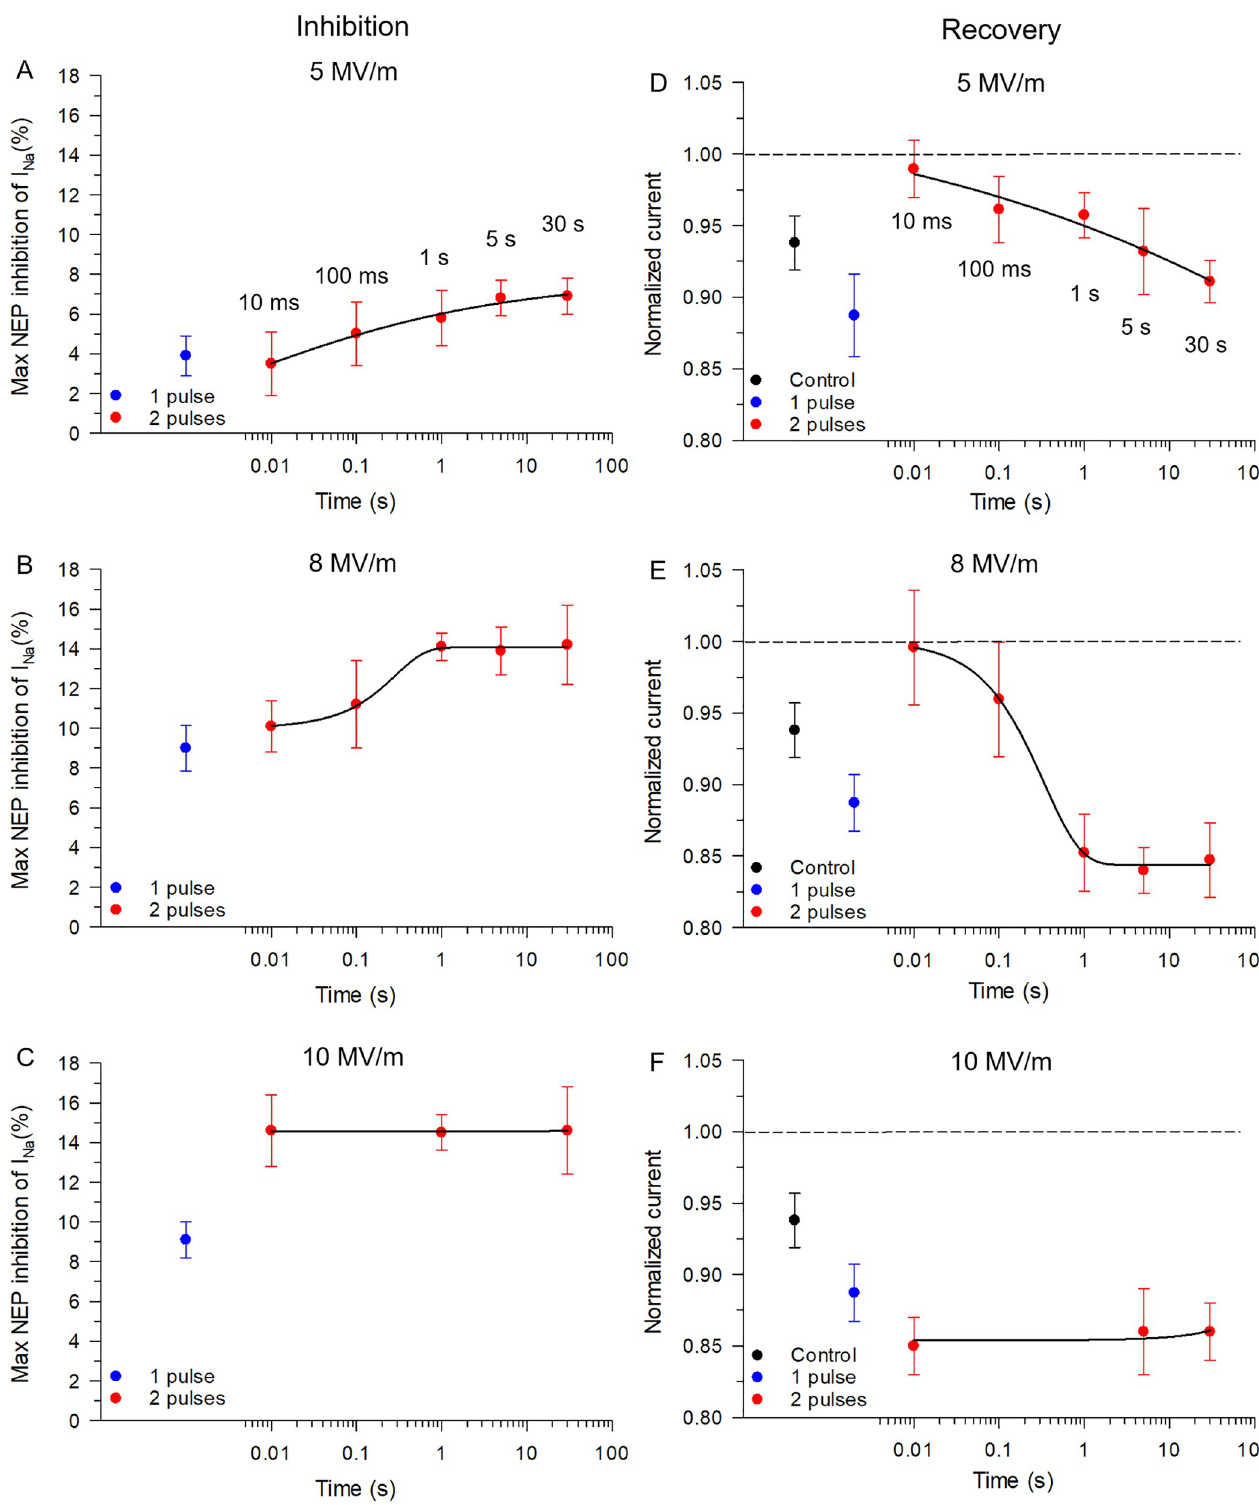
Fig 6. Time interval and E-field strength dependence of the inhibitory and recovery effect of twin NEPs on I Na . For the left panel (inhibitory), each semi- logarithmic plot reports the mean ± SE % inhibition of peak inward Na + current elicited in cells exposed to a single pulse (blue circles), or cells exposed to twin NEPs (red circles) as a function of the interval between the pulse pair at an E-field of 5 MV/m (A), 8 MV/m (B) or 10 MV/m (C), respectively. For the right